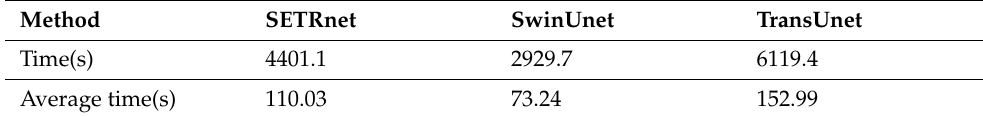
Table 1. Training time of the Vaihingen data set.